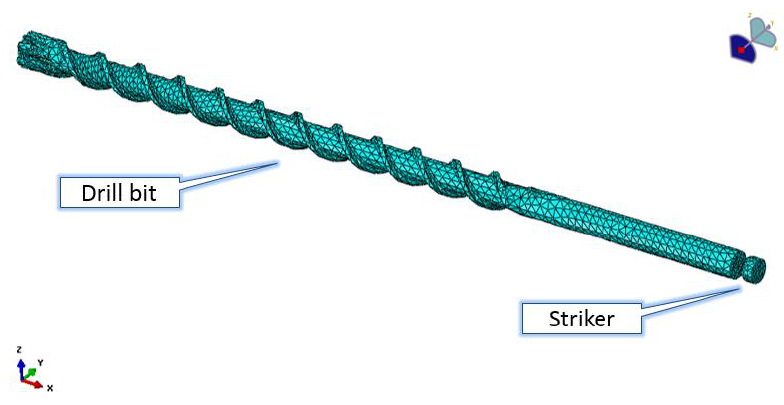
Figure 3. FE model of the drill bit with the striker.